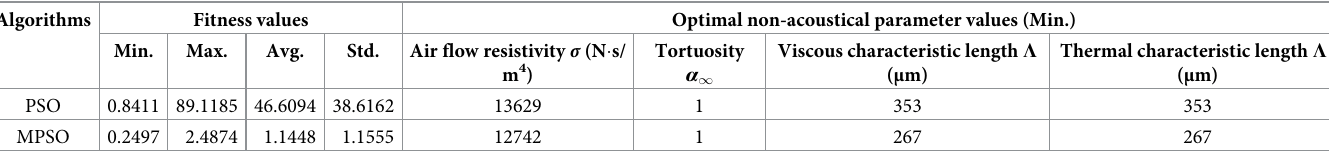
Table 3. Comparison of the identification results by the PSO and MPSO algorithms. Algorithms Fitness